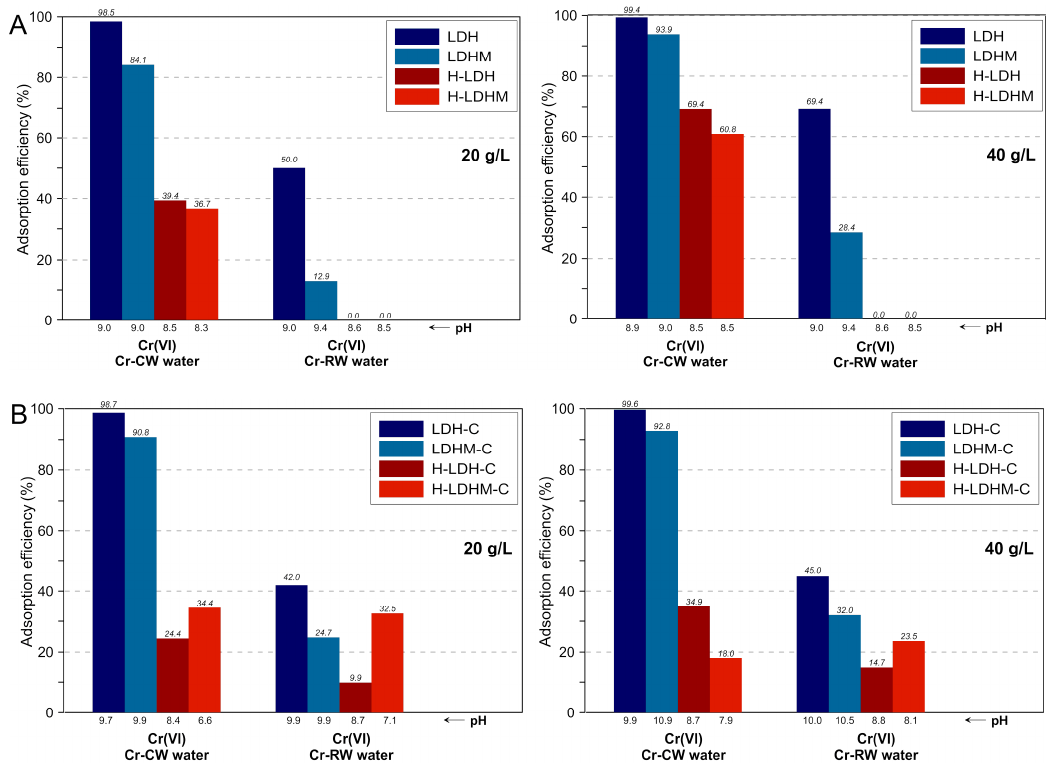
Figure 7. Comparison of Cr(VI) removal from multi-element systems versus adsorbent doses: ( A ) uncalcined materials and ( B ) calcined materials.